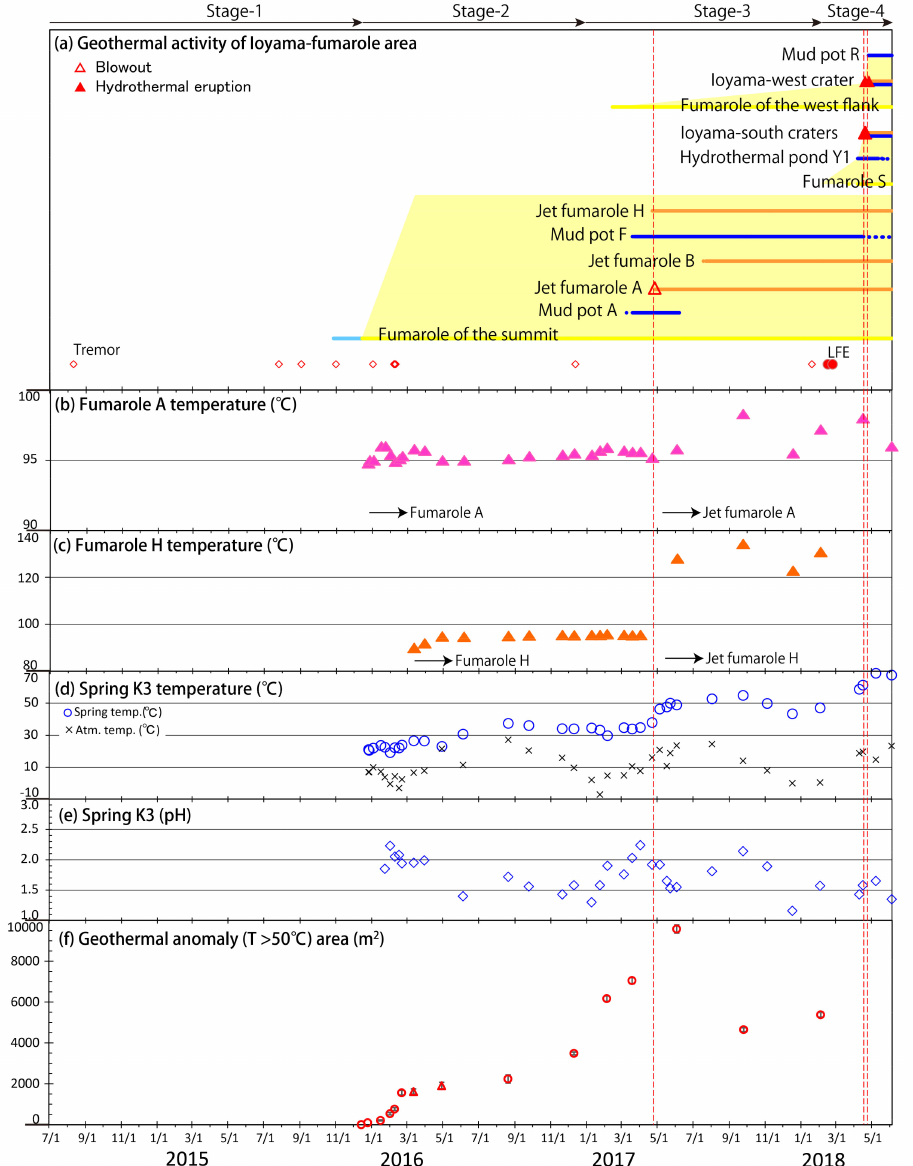
Figure 4. The sequence of geothermal activities at Ebinokogen Ioyama Volcano from July 2014 to June 2018. Geothermal locations are shown in Figure 3. ( a ) Yellow areas and bars denote the activity of Ioyama-fumarole area. Light blue line indicates a sulfur smell. Orange line denotes a jet fumarole. Blue line denotes a mud pot or hydrothermal pond. Tremor and low-frequency earthquake (LFE) based on the Japan Meteorological Agency (JMA) web site [50]; ( b ) Temperature observed at point A, before turning into a jet and the jet fumarole A; ( c ) Temperature observed at point H, before turning into a jet and the jet fumarole H; ( d ) Water temperature observed at the spring K3; ( e ) pH of water observed at the spring K3; ( f ) Geothermal anomaly ( > 50 ◦ C) area in the summit of Ioyama. Triangles include larger error